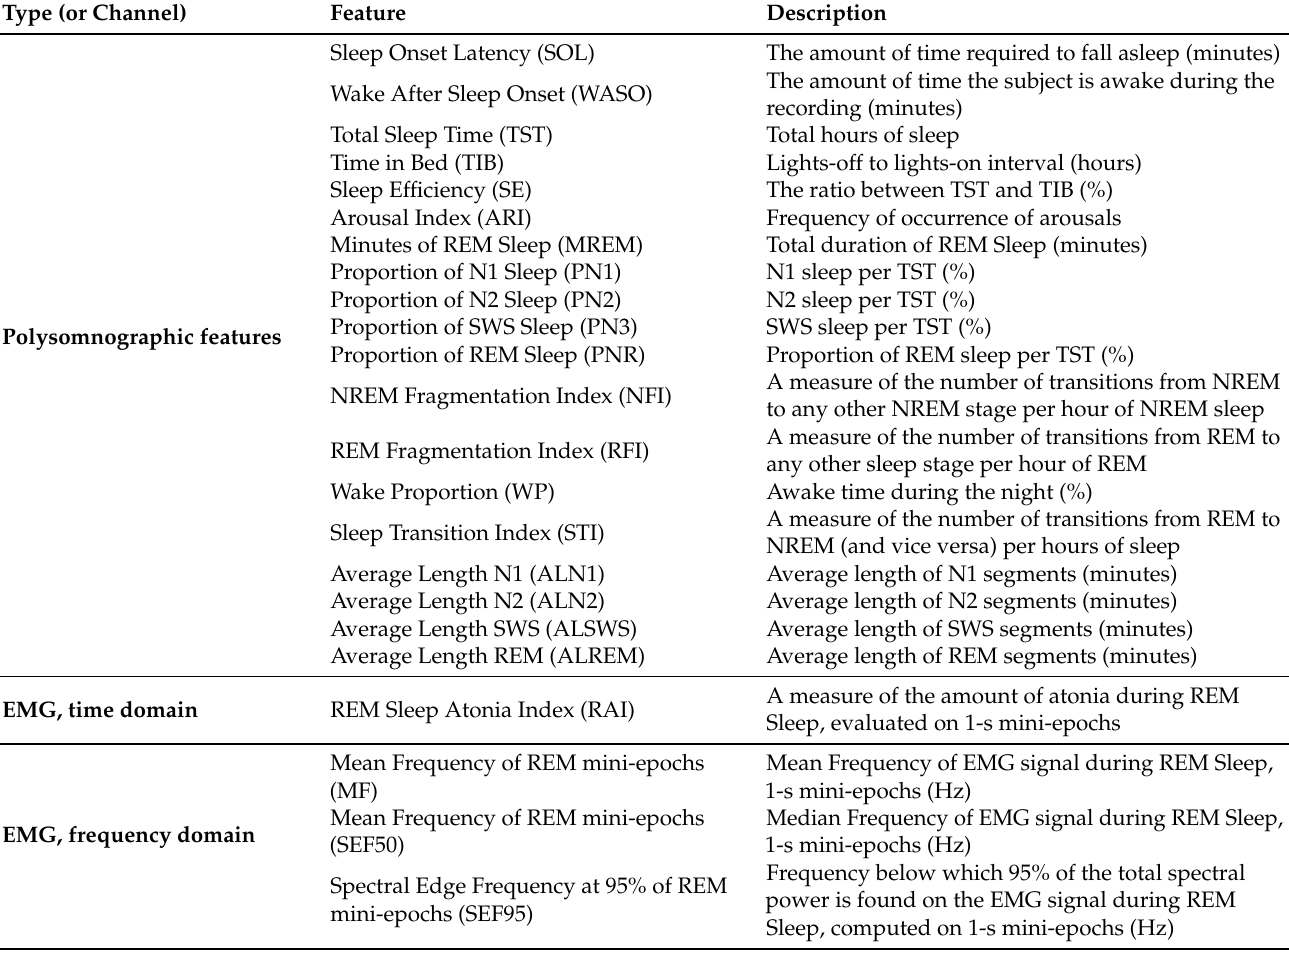
Table 1. Features employed in the study, along with their acronym and description. The extracted features are of three different kinds: polysomnographic (i.e., clinical), muscular (EMG) in the time domain, muscular (EMG) in the frequency domain. As for polysomnographic features referring to sleep stages, the following definition of sleep stage holds (according to the international